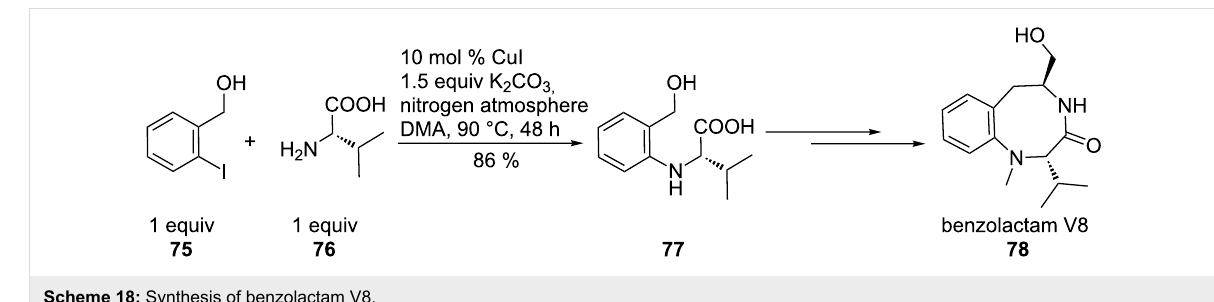
Scheme 18: Synthesis of benzolactam V8.